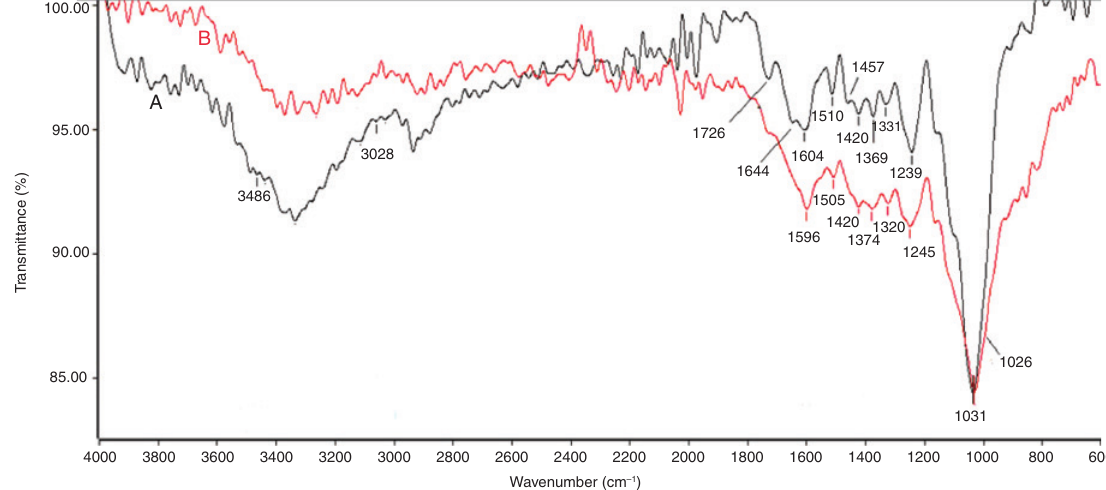
Figure 7: FTIR spectra of (A) raw and treated DPF with discharge power of 100 W and (B) exposure time of 5